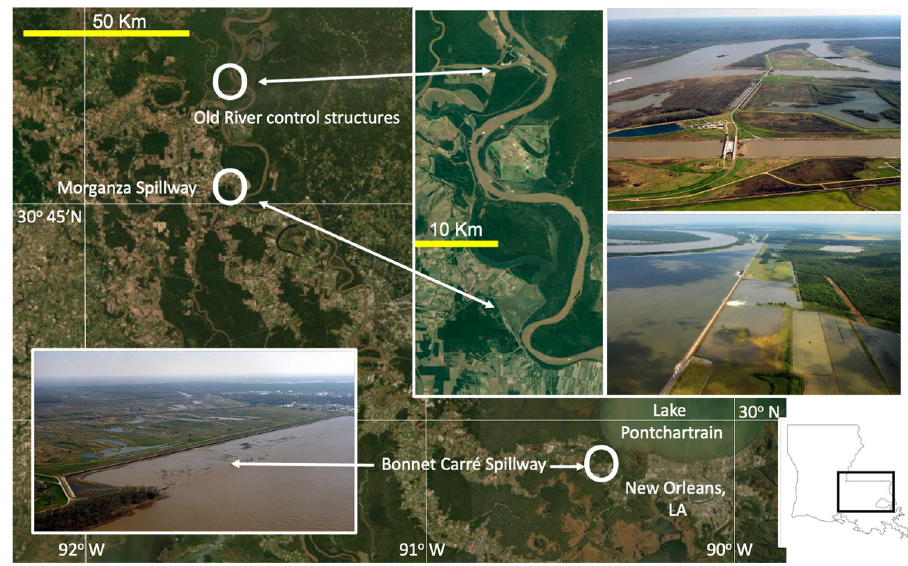
Fig 2. The three water control structures diverting water away from the main channel of the Mississippi River before it reaches New Orleans, LA. The most upstream is the Old River Control Structure that has three channels bringing river water westward where it joins the Red River to form the Atchafalaya River. The Morganza Spillway, located downstream, has been opened twice during extremely high flows. The Bonnet Carre´ Spillway brings water into Lake Pontchartrain located on the north shore of New Orleans, LA. The satellite imagery is from a one-meter resolution coastal Digital Orthophoto Quarter Quadrangle (DOQQ) imagery provided by the U.S. Geological Survey to the Atlas Depository (public access) at https://maps.ga.lsu.edu/doqq2008/. The spillway photographs are from the U. S. Army Corps of Engineers Digital Visual Library (public access) at